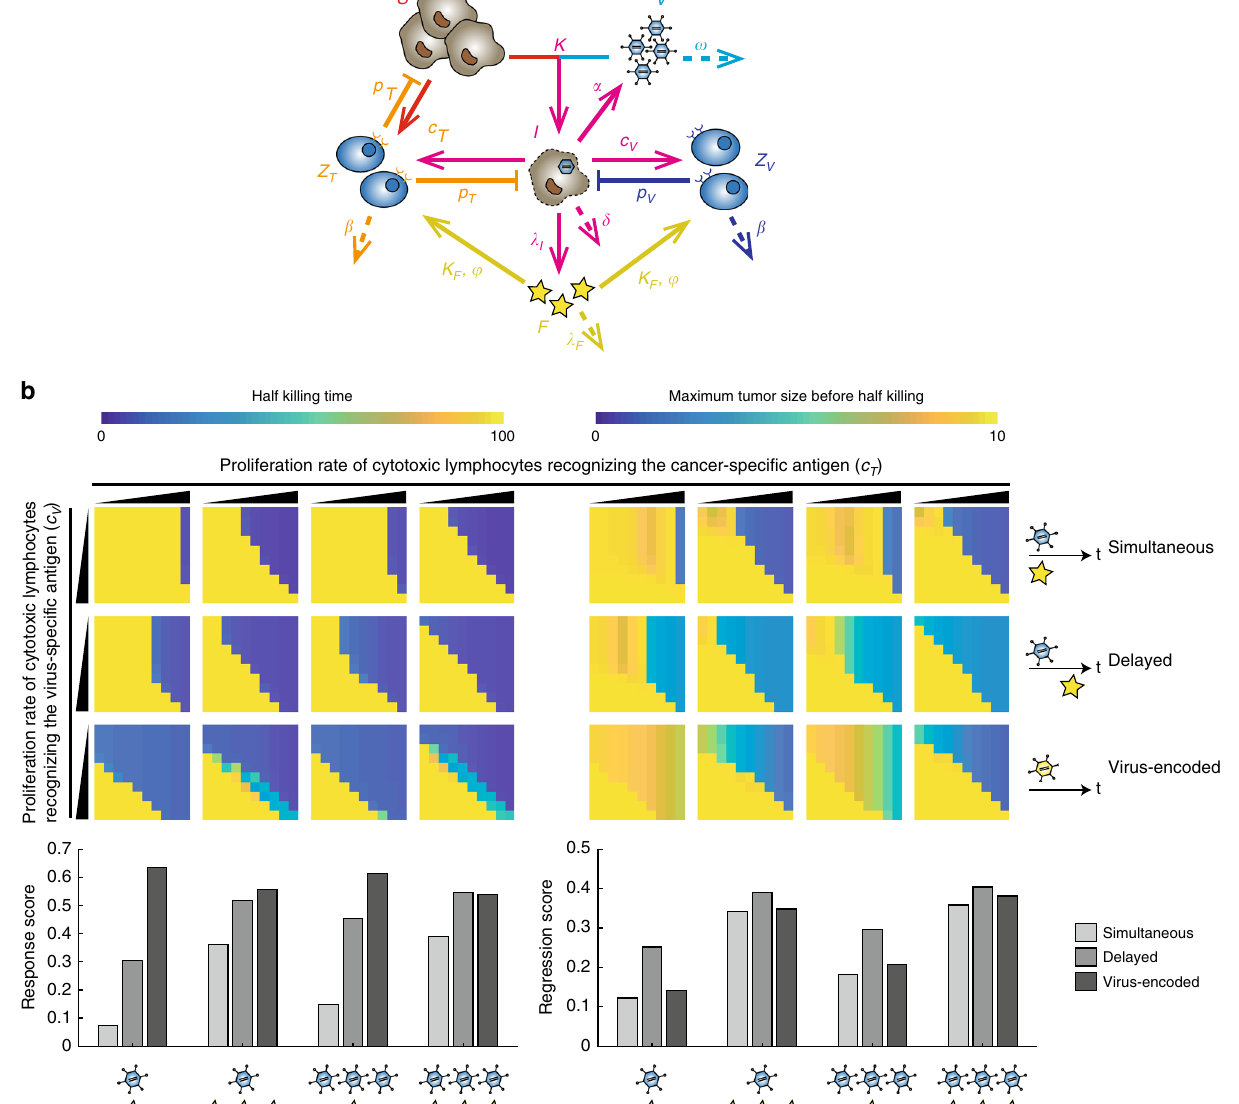
Fig. 7 Modeling of oncolytic virus therapeutic system. a Schematic diagram of the model with uninfected ( S ) and infected ( I ) cancer cells, free viruses ( V ), cytotoxic lymphocytes recognizing virus-speci fi c antigen ( Z V ) and cancer-speci fi c antigen ( Z T ), and immune effectors ( F ). Parameters are explained in “ Methods ” . b Predicted therapeutic ef fi cacy of different administration strategies of replicable virus and immune effector, where immune effector was administrated along with or after the virus injection, or encoded by the virus. The initial amount of virus (MOI = 5 (one virus symbol) or 50 (three virus symbols)) and initial amount or production rate of immune effectors (10 a.u. (one star symbol) or 50 a.u. (three star symbols)) are noted on the bottom. Calculation of half killing time, maximum tumor size before half killing, response score and regression score is explained in “ Methods ” . Each matrix shows parameter combinations of c V (10 1.6 ~ 10 3.5 a.u.) and c T (10 1.2 ~ 10 3.1